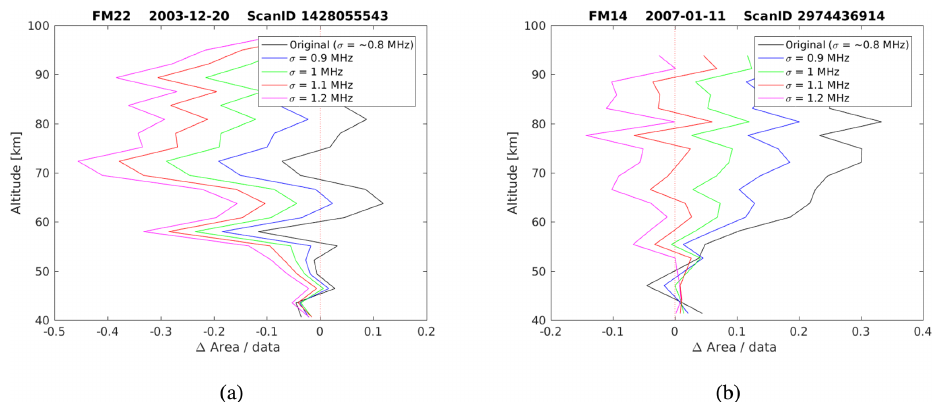
Figure 6. Relative difference between the Gaussian area beneath the observed CO line and the Gaussian area beneath the fit, obtained with different response functions for a scan in the PLL working period (a) and non-working period (b) . The best response functions for the two cases are, respectively, the original one (black line) and the one with σ = 1 . 1MHz (red line).